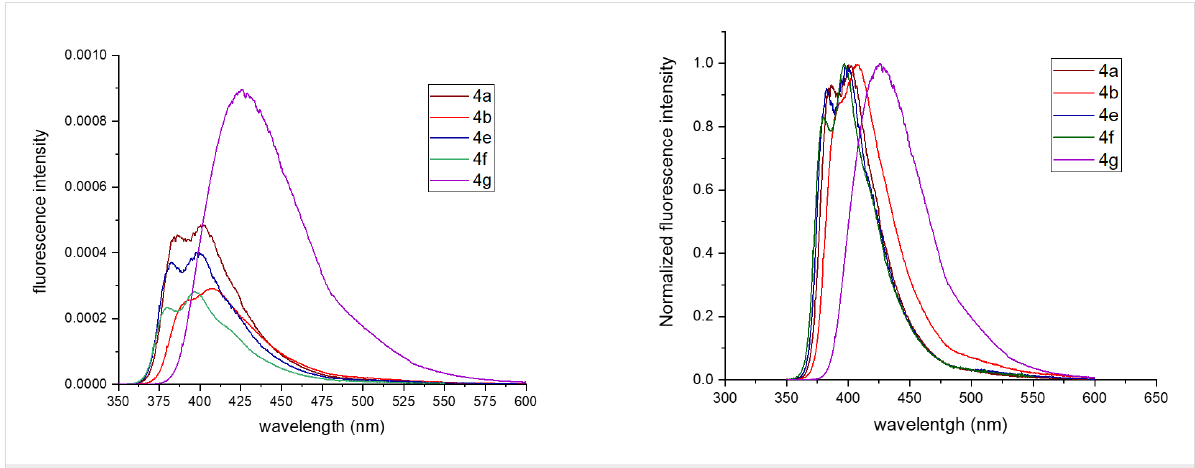
Figure 3: Emission spectra of 4a , b and 4e–g in diluted dichloromethane solutions at room temperature ( c = 1 × 10 − 5 M).